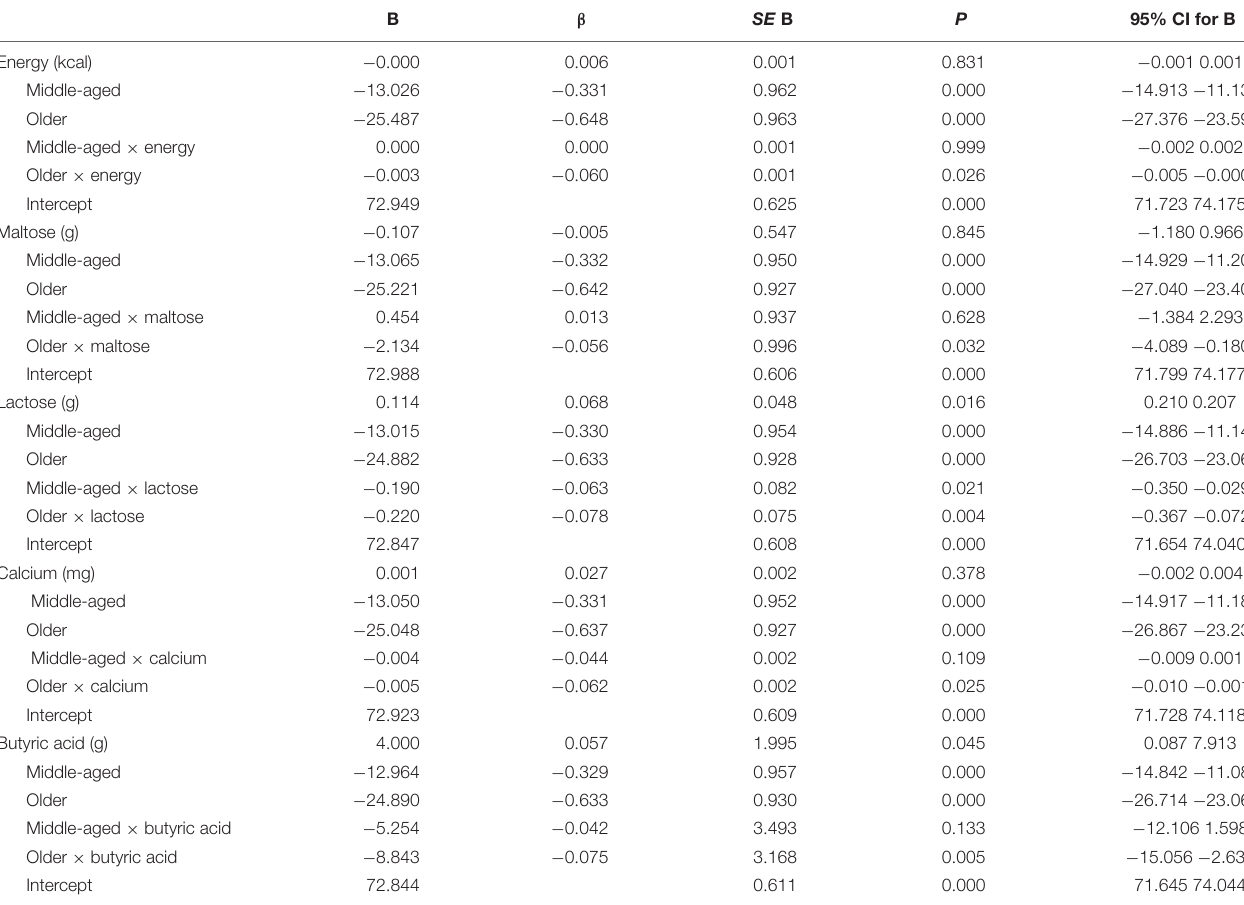
TABLE 7 | Moderator analyses